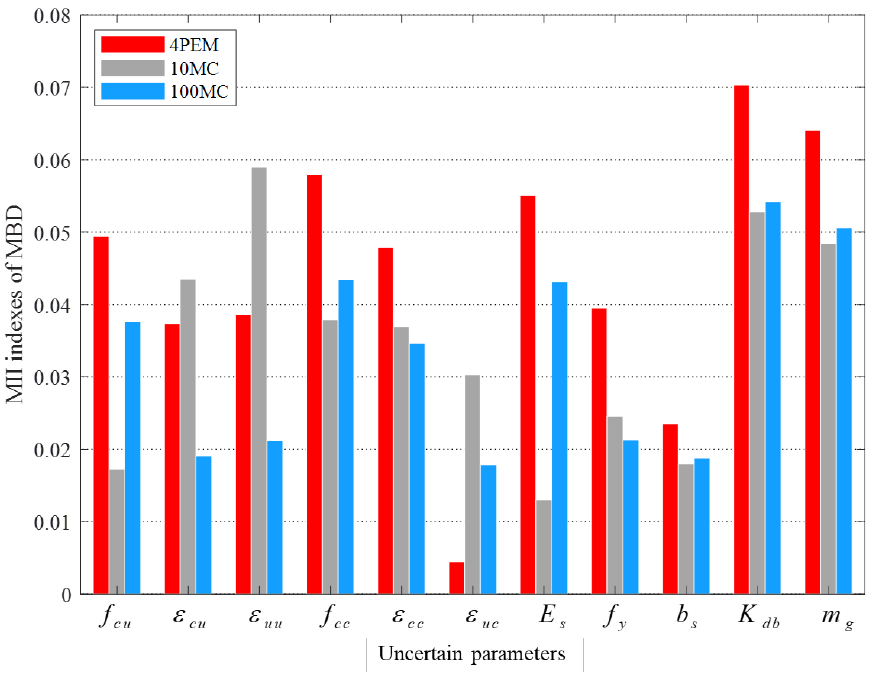
Figure 4. MII indexes of MBD.